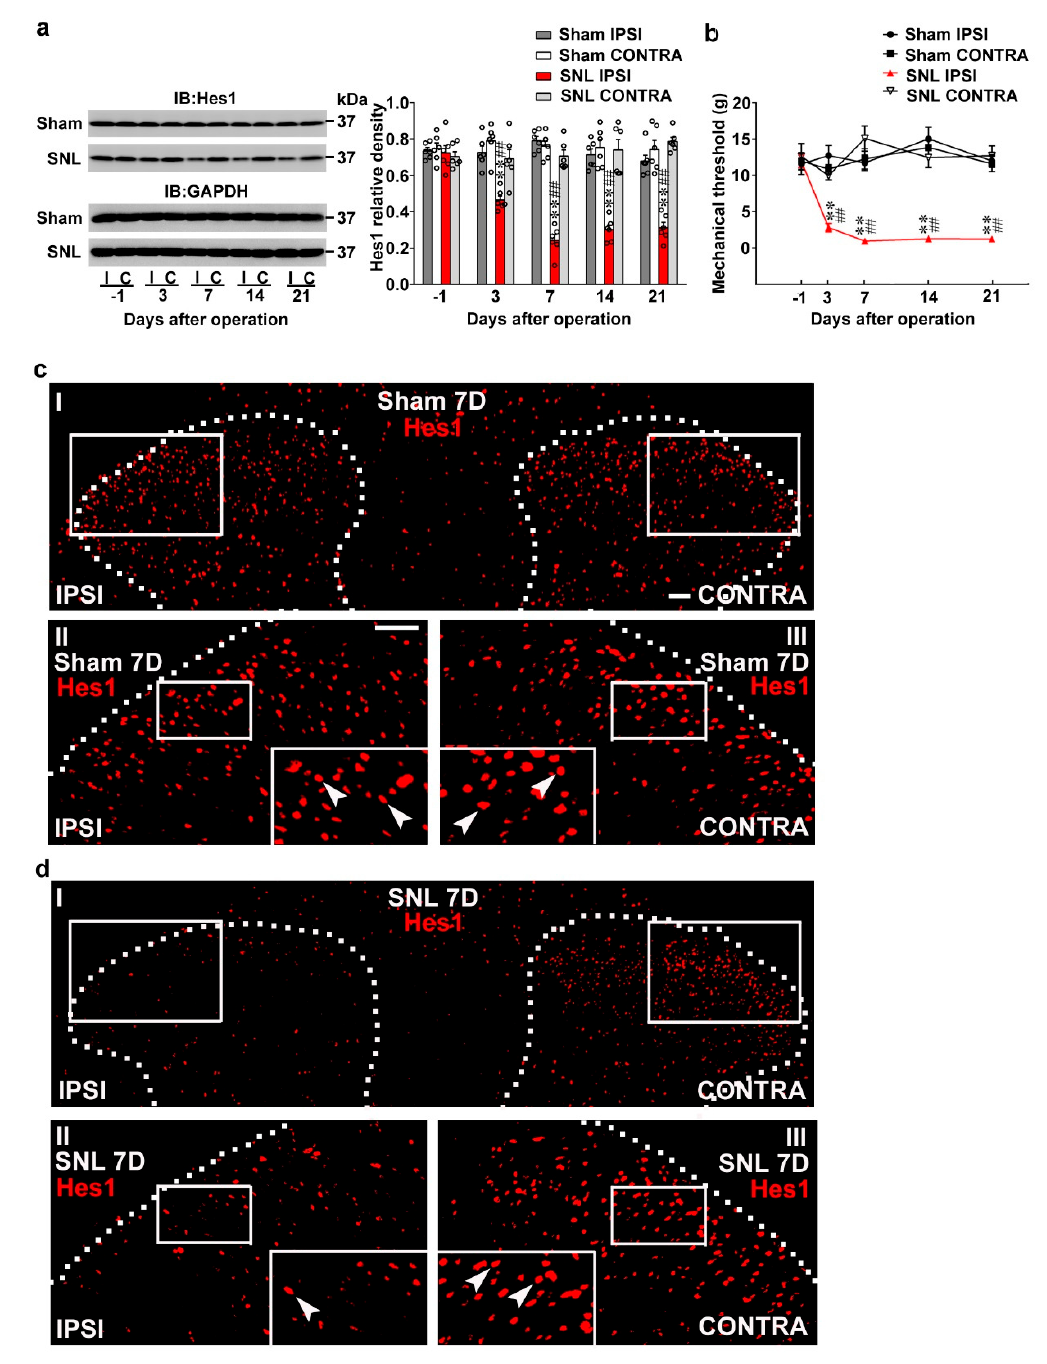
Figure 1. Nerve injury reduced spinal Hes1 expression accompanied with behavioral allodynia. ( a ) Representative Western blot and statistical analyses (normalized to GAPDH) demonstrating, when compared with the sham operation (Sham), that spinal nerve ligation (SNL) decreased the expression of Hes1 in the ipsilateral (I and IPSI) but not the contralateral (C and CONTRA) dorsal horn at days 3, 7, 14, and 21 after surgery. IB, Immunoblotting. Two ‐ way ANOVA with repeated measures over time, treatment, F (3,20) = 116.6, p < 0.0001; time, F (4,80) = 6.258, p = 0.0002; treatment × time, F(12,80) = 9.003, p < 0.0011. ** p < 0.01 vs. Sham IPSI. ## p < 0.01 vs. SNL day –1. n = 6. ( b ) Von Frey test demonstrating, when compared with the sham operation, that SNL decreased the tactile withdrawal threshold of the ipsilateral but not the contralateral hind ‐ paw at days 3, 7, 14, and 21 after surgery. Two ‐ way ANOVA with repeated measures over time, treatment, F (3,24) = 59.37, p < 0.0001; time, F(4,96) = 4.514, p = 0.0022; treatment × time, F(12,96) = 6.427, p < 0.0001. ** p < 0.01 vs. Sham IPSI. ## p <